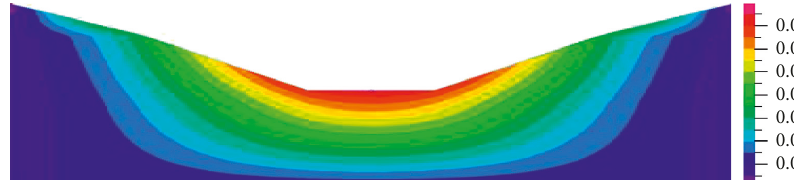
Figure 13: Displacement cloud map after excavation (unit: m).